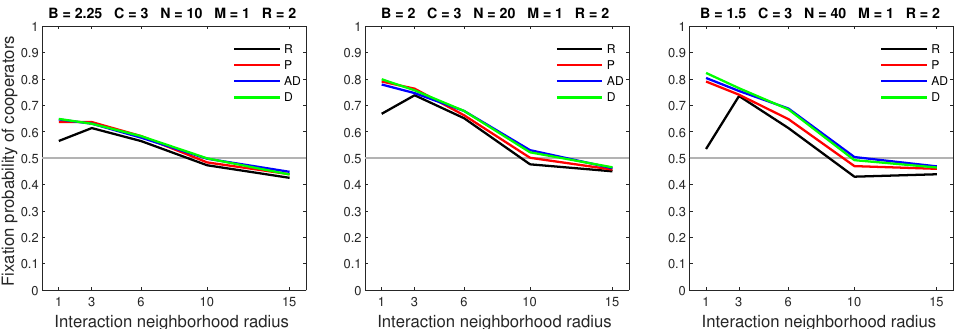
Figure 17. When the mobility rate is low and the dispersal range is sufficiently large, all forms of success-driven mobility result in higher fixation probabilities than random dispersal in neighborhoods of radius 1.